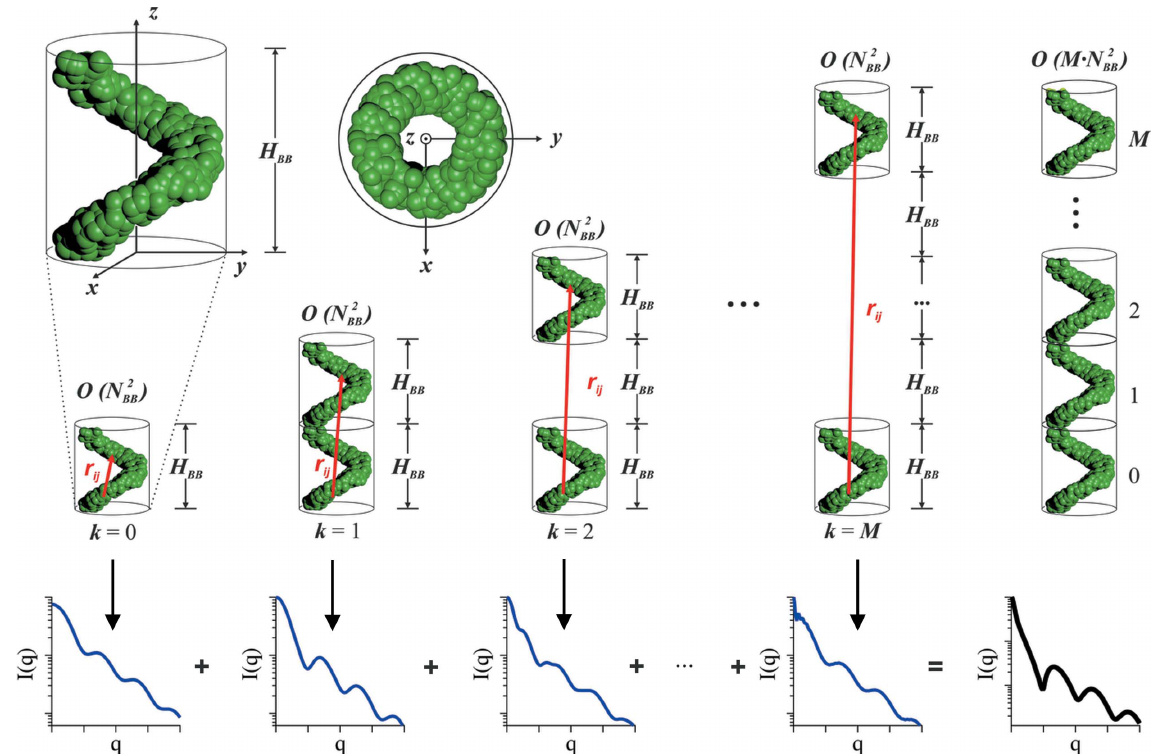
Figure 1 The projection scheme, visualized using the example of a single-stranded helix. For such seemingly endless geometries, there is a building block (upper left-hand corner) that is recurrent along the z axis (see full helix on the right). For a full body consisting of M stacked building blocks, one finds distinct structural motifs, such as the building block itself, neighbouring building blocks, single-spaced building blocks and so on up to ( M (cid:3) 1)-spaced building blocks. The scattering intensity of the full geometry can hence be calculated by summing the contributions of these structural motifs, scaled by their recurrence. This bypasses the demand for an actual DA model representing the full structure, as we solely evaluate projections of the building block instead of actual stacked duplicates, hence the term projection